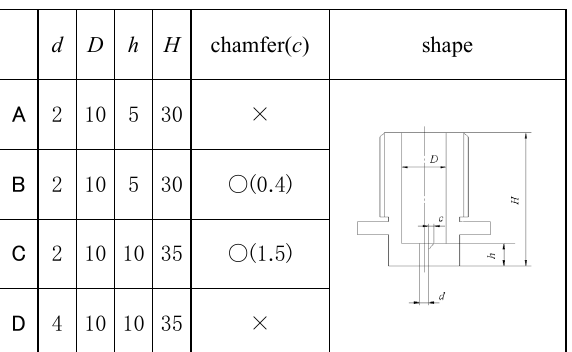
Table 1 Shape of nozzle